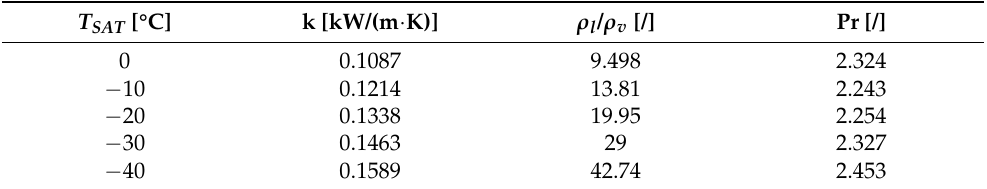
Table 5. Variation in properties (thermal conductivity, density ratio, and Prandtl number) with respect to different saturation temperatures.